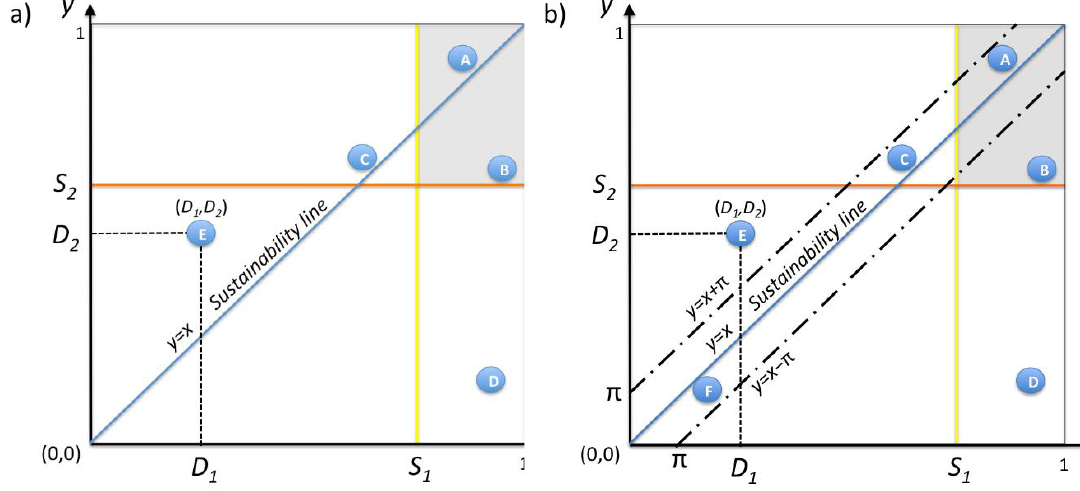
Figure 1. ( a ) 2D space with the zone of city smartness (in grey) and ( b ) sustainability corridor.